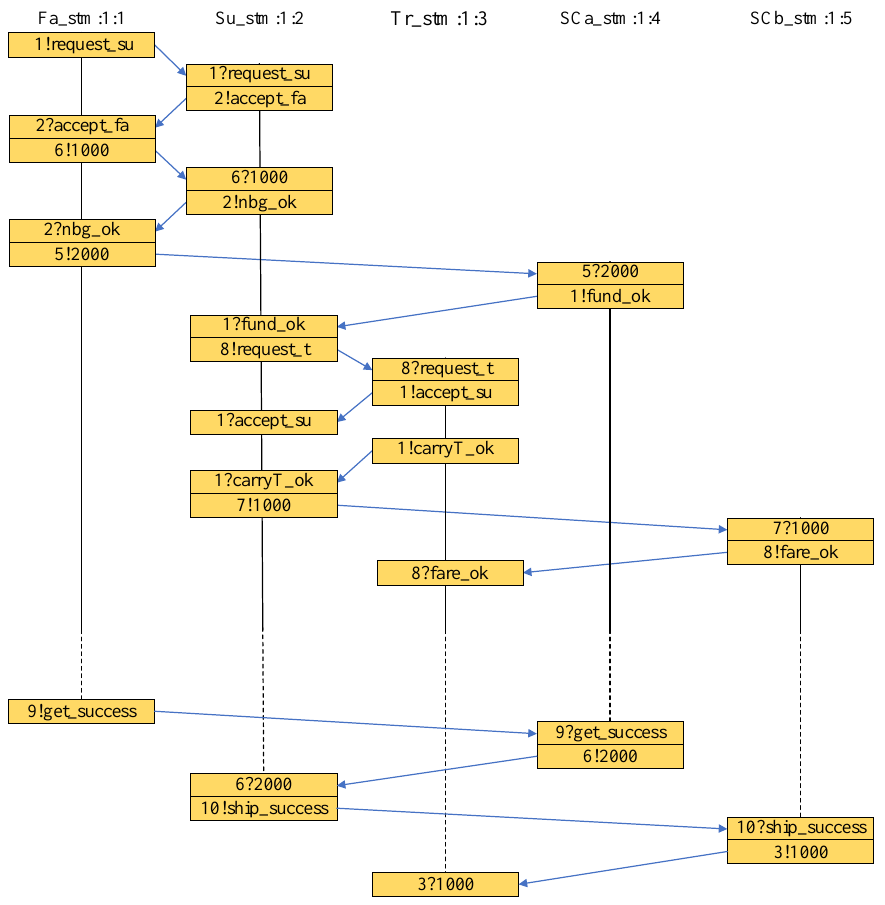
Figure 11. Message sequence